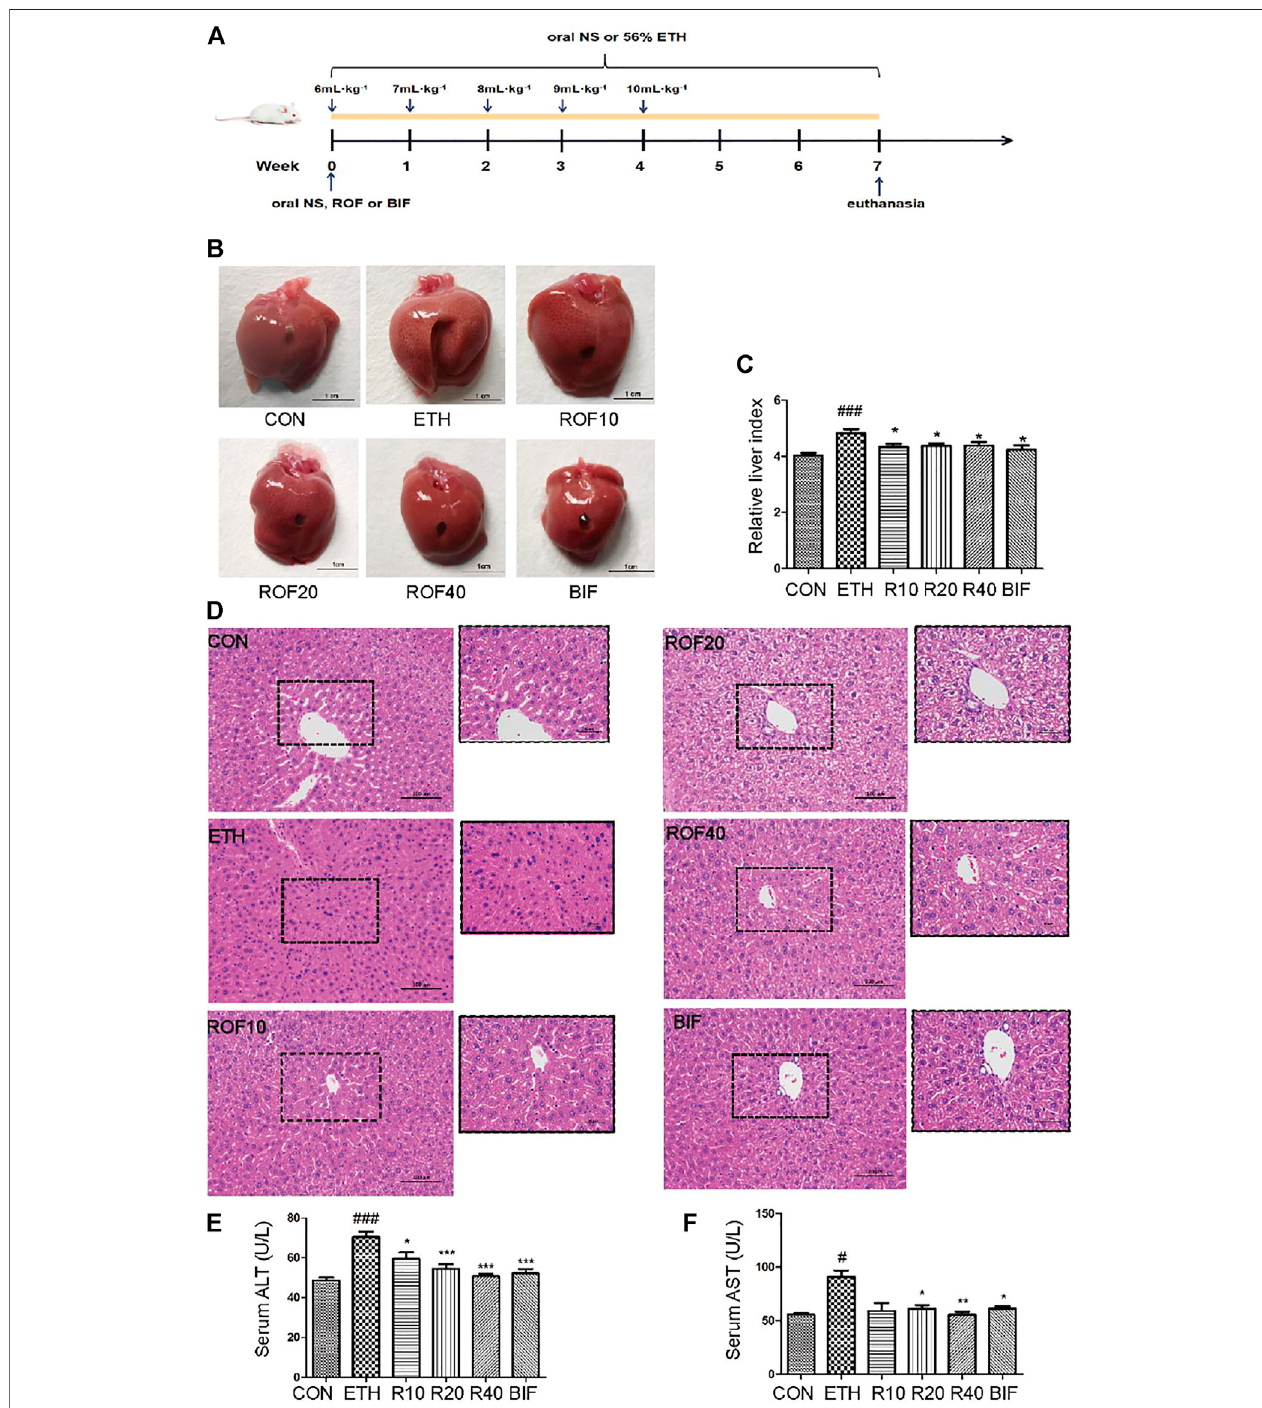
FIGURE 1 | Effects of ROF on histopathological changes and hepatic index in ALD mice. The time fl owchart is shown in (A) . Macroscopic appearance of liver tissues (B) andhepaticindex (C) . (D) Histopathologyanalysisofliverdamage(200×and400×).TheserumconcentrationsofALT (E) andAST (F) .Mean±SEM( n =6 – 9). * p < 0.05, ** p < 0.01 and *** p < 0.001 vs. the ETH group. ## p < 0.01 and ### p < 0.001 vs. the CON